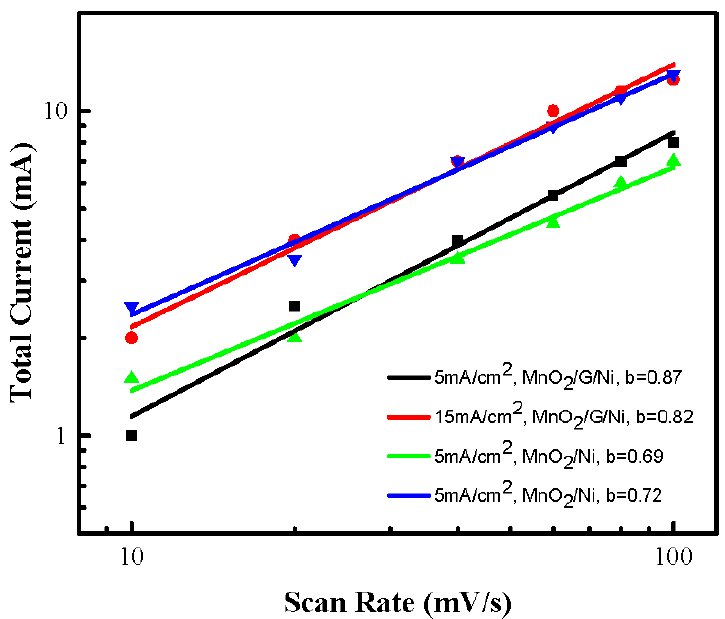
Figure 6. The b parameter of the MnO 2 /Ni and MnO 2 /graphene/Ni electrodes obtained from different electrodeposition conditions.